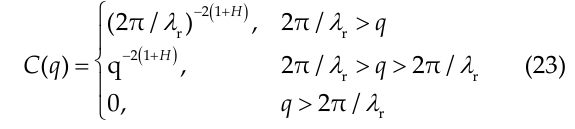
Table 1 Dimensionless contact parameters of a rigid body with an elastic half-space.